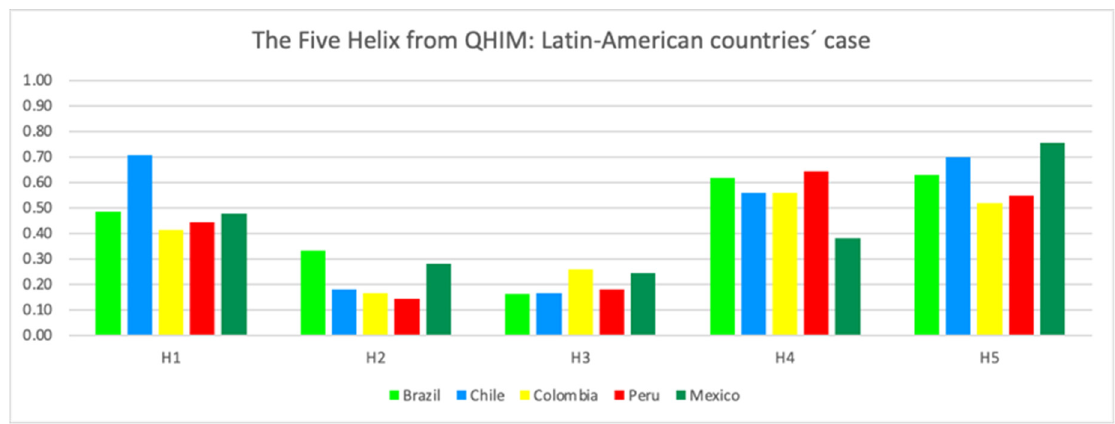
Figure 6. Social Capital (SC). Source: Own elaboration based on [45,51,52]. Figure 7 reveals the overall result of the five helices. Also, Table A4 shows the results of QHIM per each helix and country. The result of each helix is the average value of the four indicators per block. Social capital led the ranking (0.63), followed by ecological cap- ital (0.55). Political capital would be in third position (0.51), followed by human capital (0.22) and economic capital (0.20). Chile led in H1, Brazil in H2, Colombia in H3, Peru in H4, and Mexico in H5.